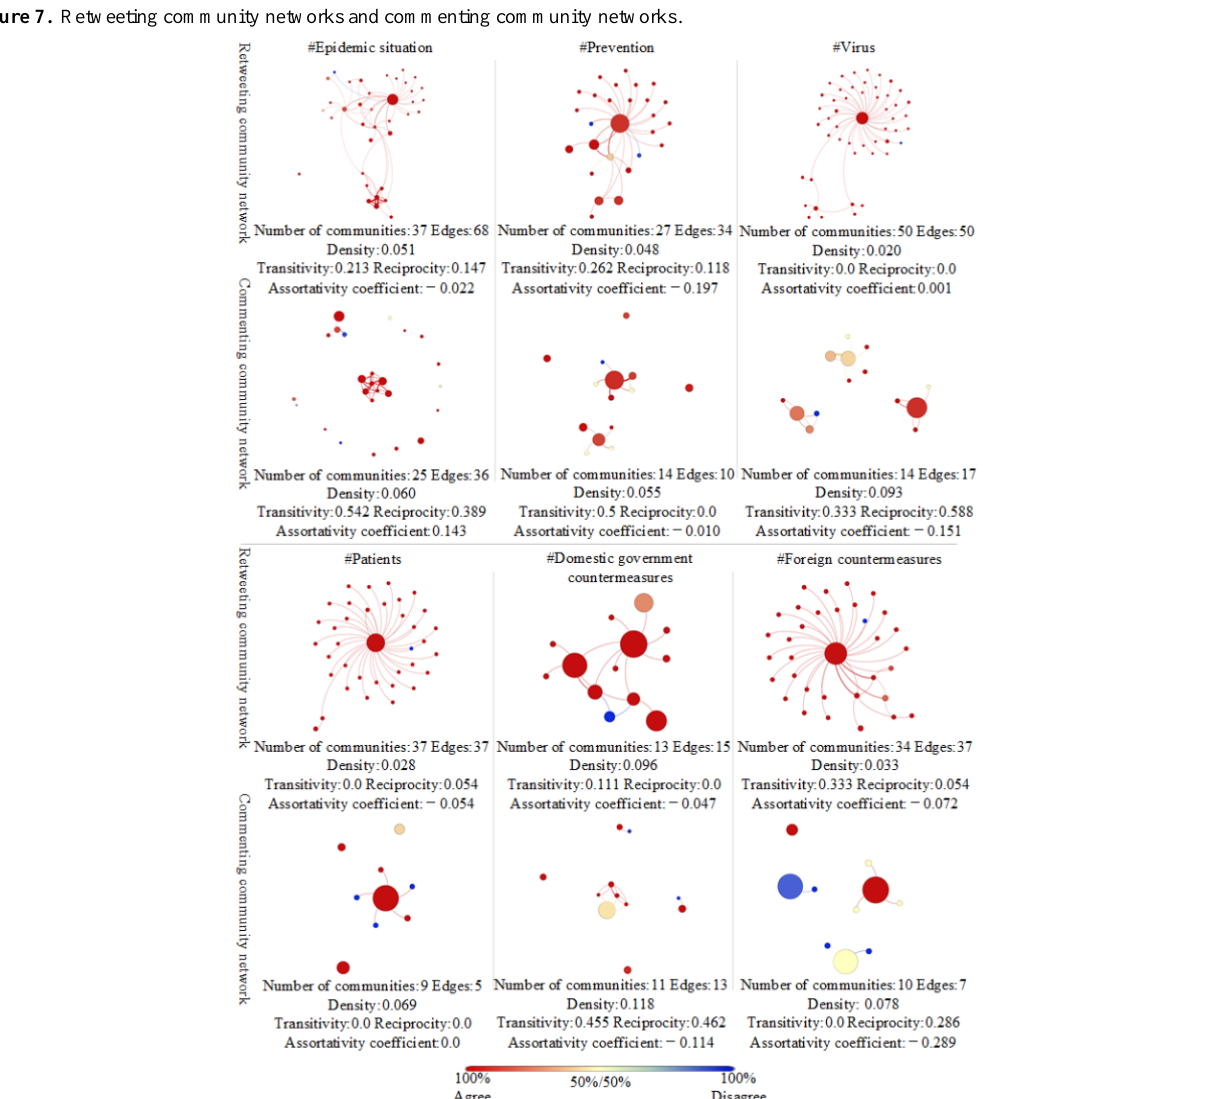
Figure 7. Retweeting community networks and commenting community